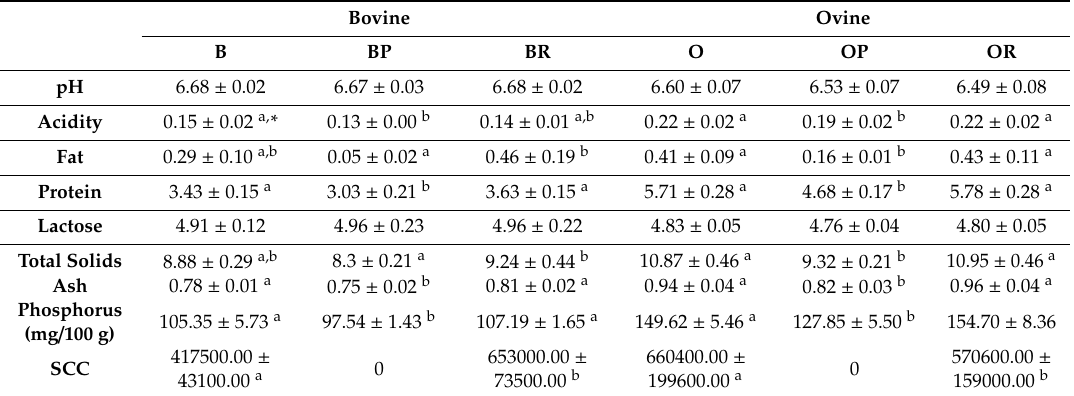
Table 1. E ff ect of microfiltration on pH, acidity, somatic cells counts (SCC) and chemical composition (%) of partially defatted bovine (B) or ovine (O) milk, bovine permeate (BP), bovine retentate (BR) (mean ± SD, n = 3), ovine permeate (OP) and ovine retentate (OR) (mean ± SD, n = 5). Bovine Ovine B BP BR O OP